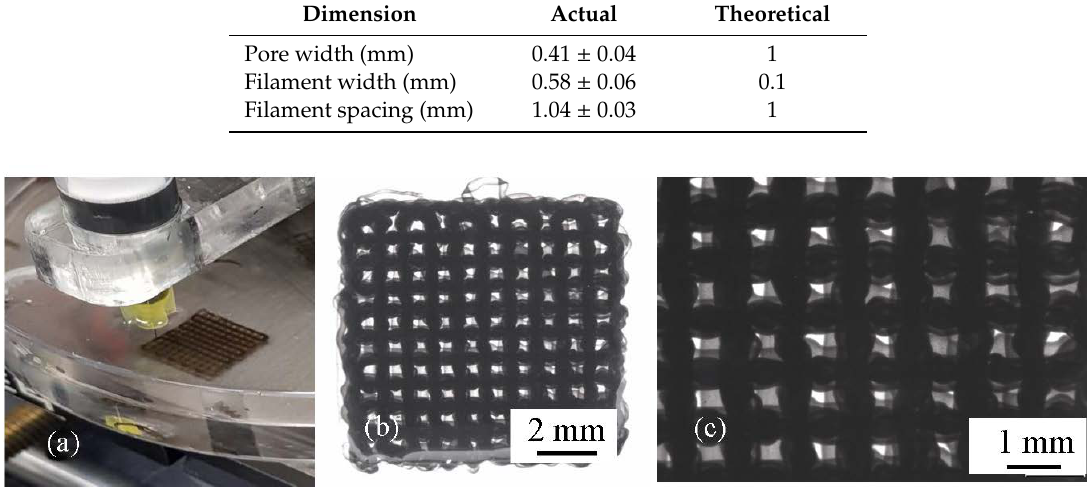
Figure 6. Structure of printed sca ff olds using composite B: ( a ) extrusion printing of ink; ( b ) low magnification (10 × ); ( c ) high magnification (30 ×